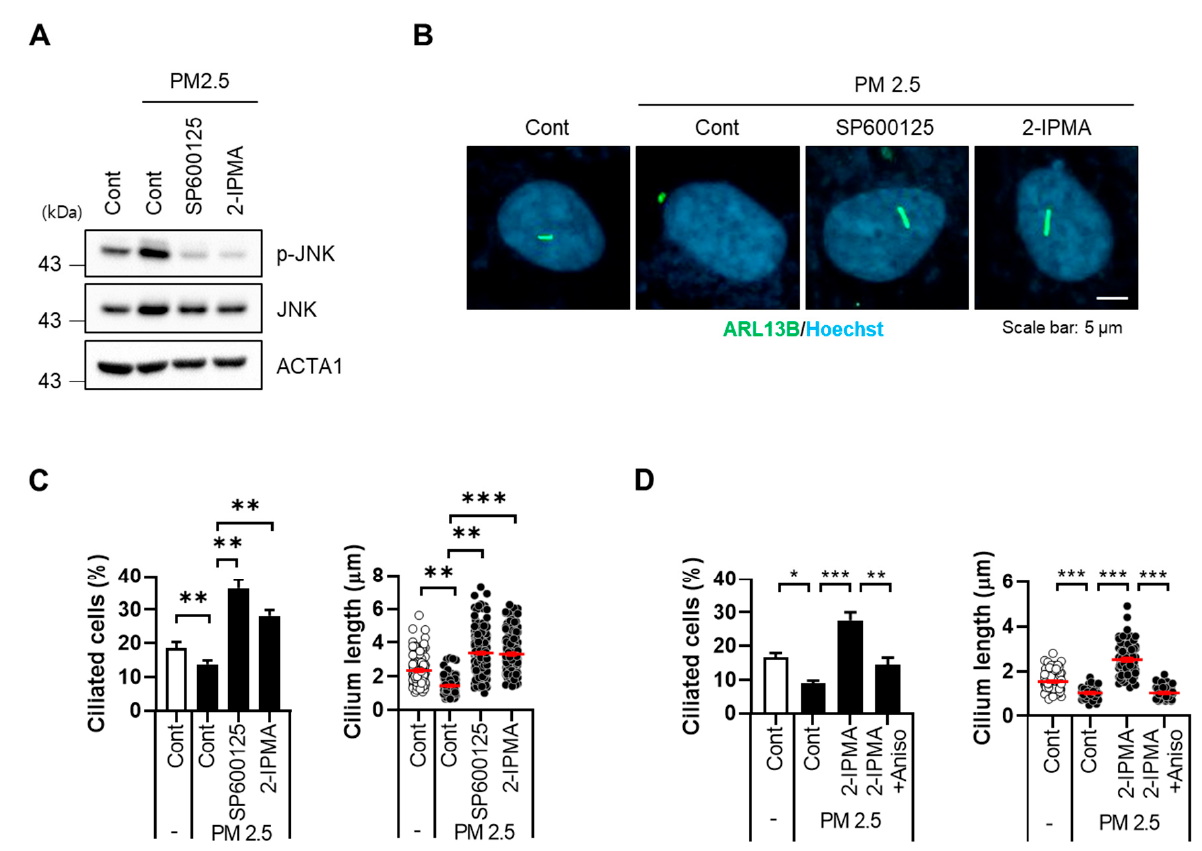
Figure 4. 2-IPMA inhibits PM2.5-induced JNK activation in RPE cells. RPE cells were exposed to PM2.5 (50 μ g/mL) with either 2-IPMA (100 µ M)/SP600125 (10 µ M) or 2-IPMA (100 µ M)/anisomycin (1 µ g/mL) for 24 h. Then the cells were harvested and analyzed by Western blotting with indicated antibodies ( A ). The cells were stained with ARL13B antibody (green) and Hoechst dye (blue) ( B ). Both ciliated cells and cilium length of the cells were measured under a fluorescence